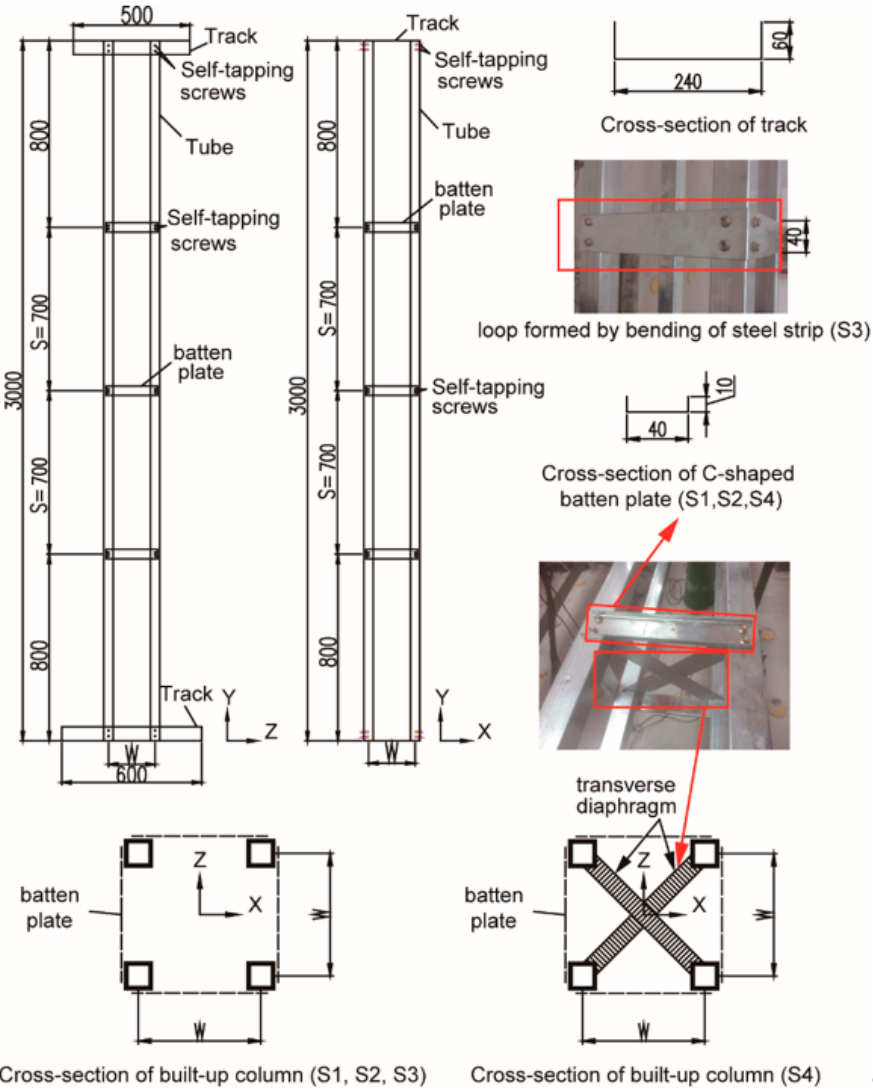
Figure 1. Configurations of specimens (unit: mm).